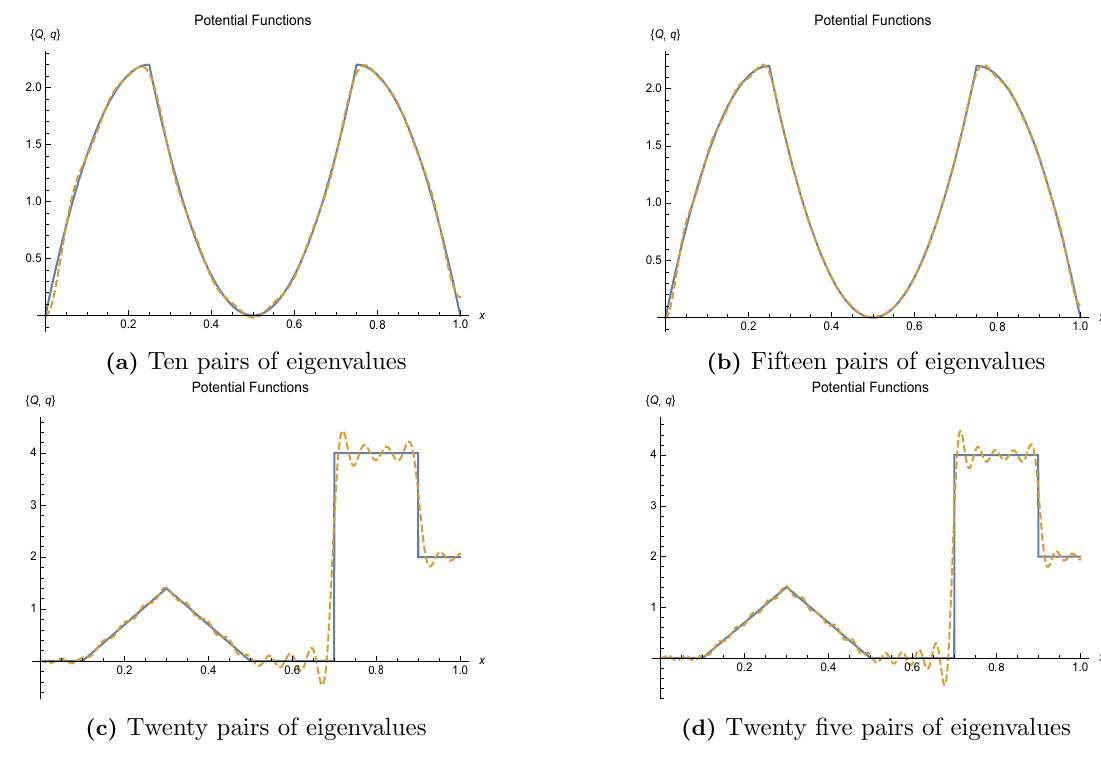
Figure 2. The graphics obtained for Q 2 ( x ) in (a), (b) and Q 3 ( x ) in (c),